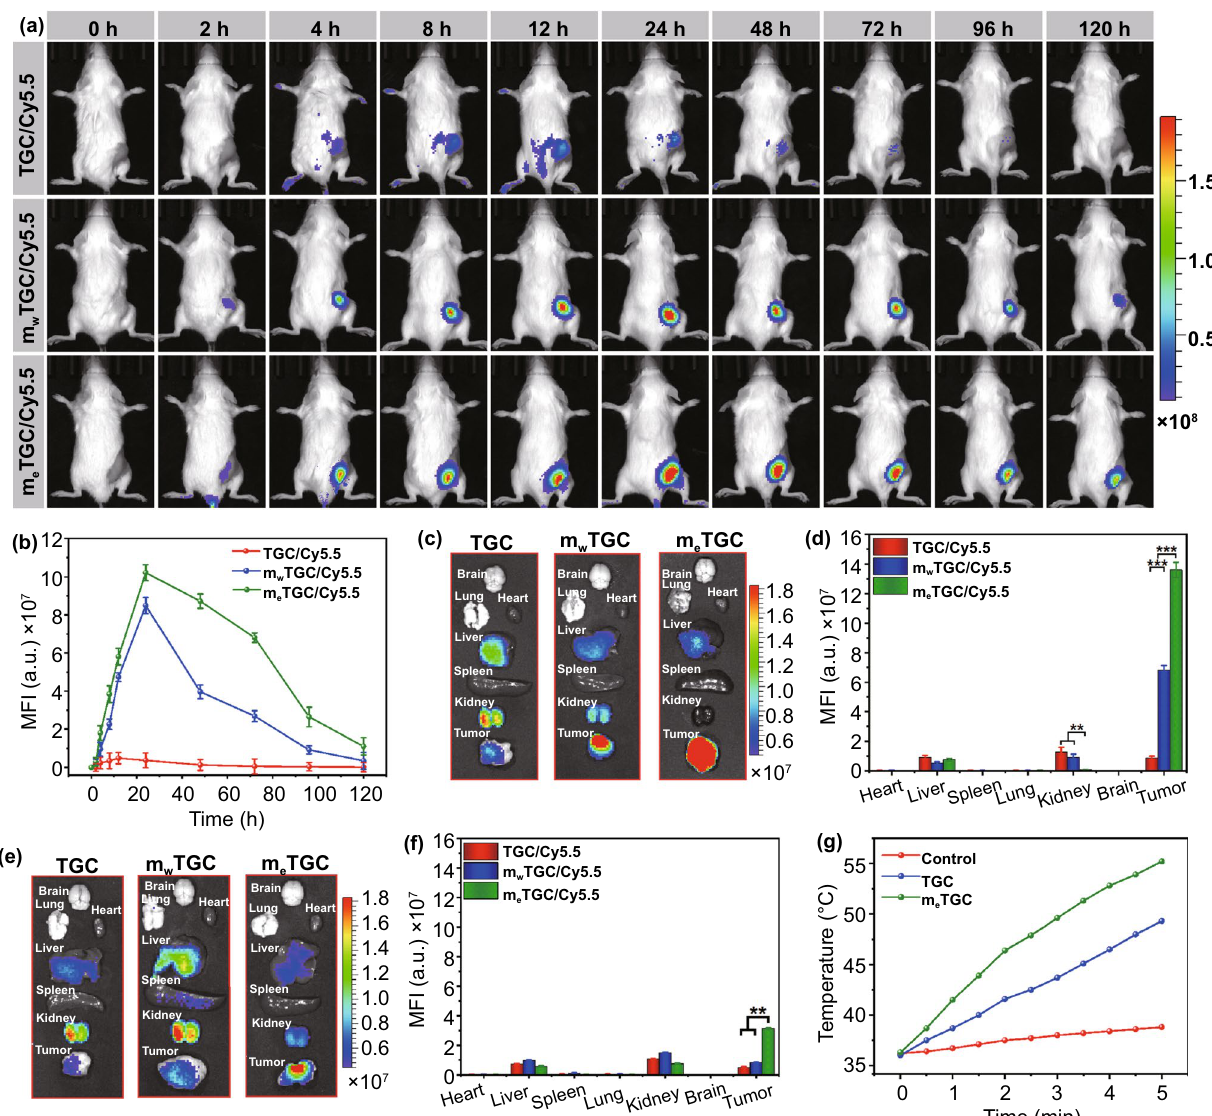
Fig. 6 a Biodistribution of TGC/Cy5.5, m w TGC/Cy5.5, and m e TGC/Cy5.5 in 4T1 tumor-bearing mice. b Corresponding average fluorescence intensity based on a . Fluorescence imaging of organs and tumor c at 24 h and e at 120 h post-injection. Corresponding average fluorescence intensity of major organs and tumor at 24 h d based on c and 120 h f based on e . g Temperature changes of tumor region under 808 nm light (1.5 W cm −2 ) within 5 min ( ***p < 0.001, **p < 0.01, n =